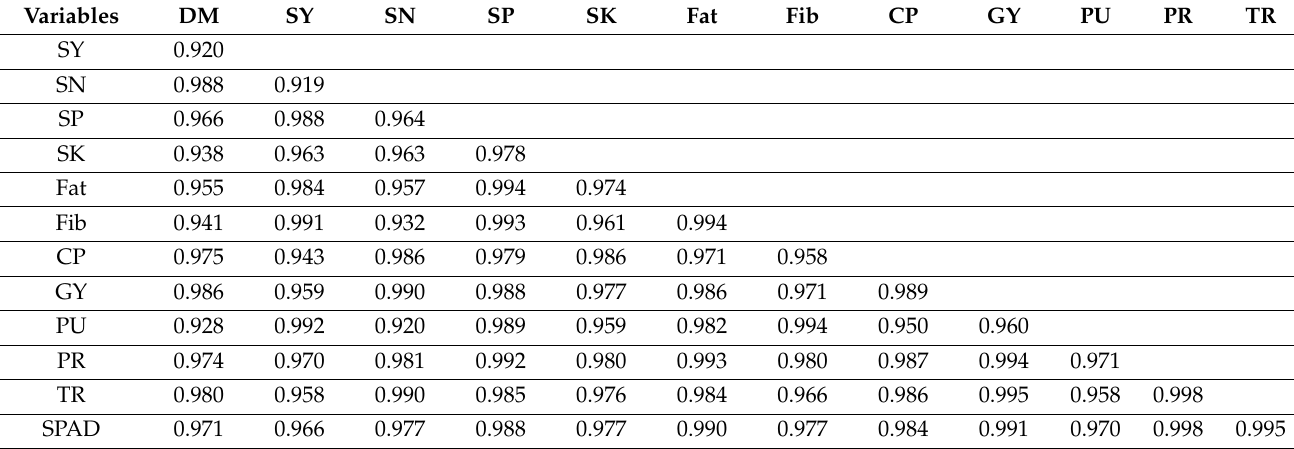
Table 4. Pearson correlation among the plant growth, physiological, biochemical nutritional parameters of wheat plantd.